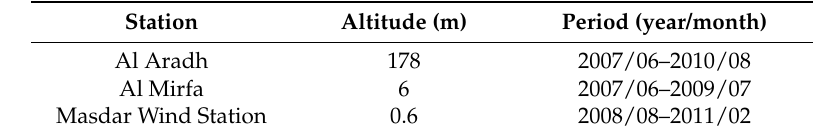
Table 2. Information on the stations used to obtain 10-min mean wind speed data.